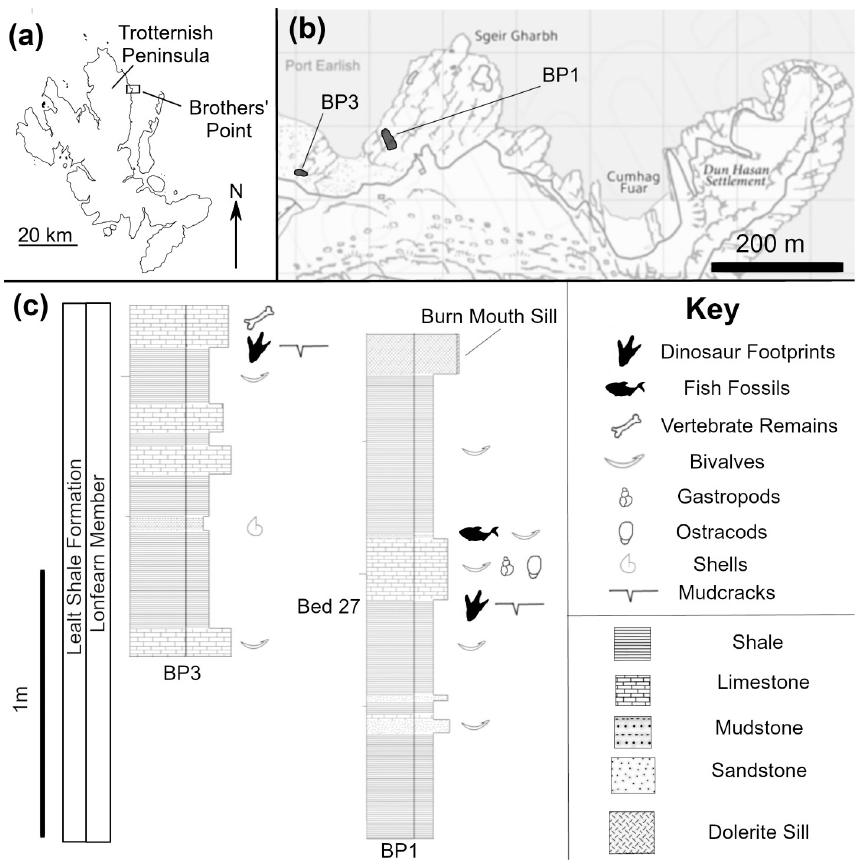
Fig 1. Geographical and geological context of BP1 and BP3. The geographical location of the sites on (a) the Isle of Skye and (b) the Trotternish Peninsula and (c) the bedding-scale stratigraphy of the Lonfearn Member, Lealt Shale Formation around each site. Bed 27 marks the inferred stratigraphic layer of the first dinosaur footprint from Scotland [22] according to the numbering scheme from [2]. It is located at or near the level of the track-bearing layer at BP1. Maps adapted from BGS 1:50 000 [Shapefile geospatial data], scale 1:50 000, tile: SC0803, version 2016, British Geological Survey, UK, using: EDINA Geology Digimap Service http://digimap.edina.ac.uk, downloaded October 2017, © Geological Map Data BGS © NERC